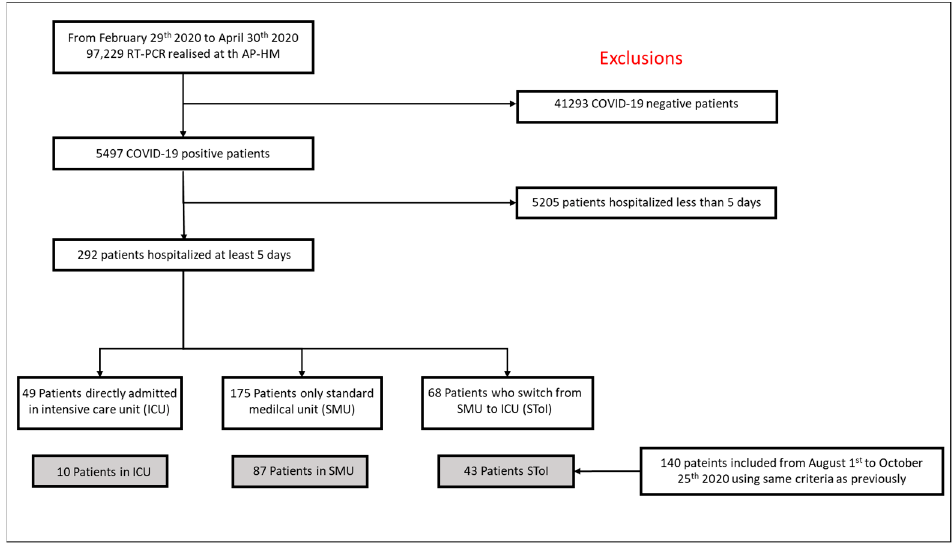
Figure 1. Flow chart.